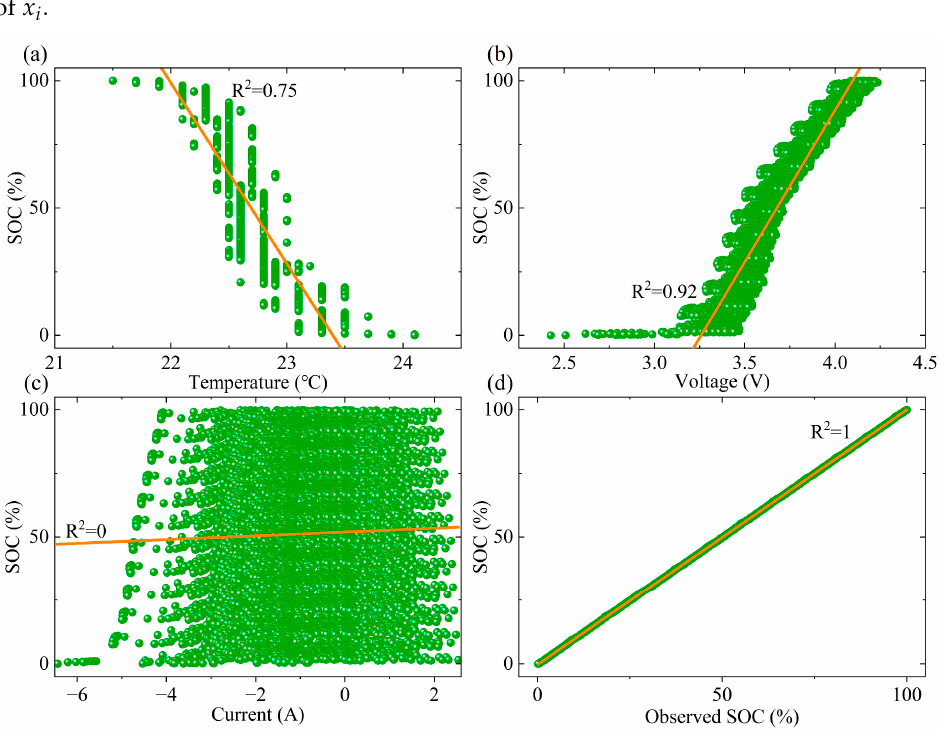
Figure 5. Correlations between four input parameters and SOC based on the ICR18650 battery when working in FUDS under 25 °C: ( a ) temperature, ( b ) voltage, ( c ) current, and ( d ) observed SOC calculated by the optimized state function.